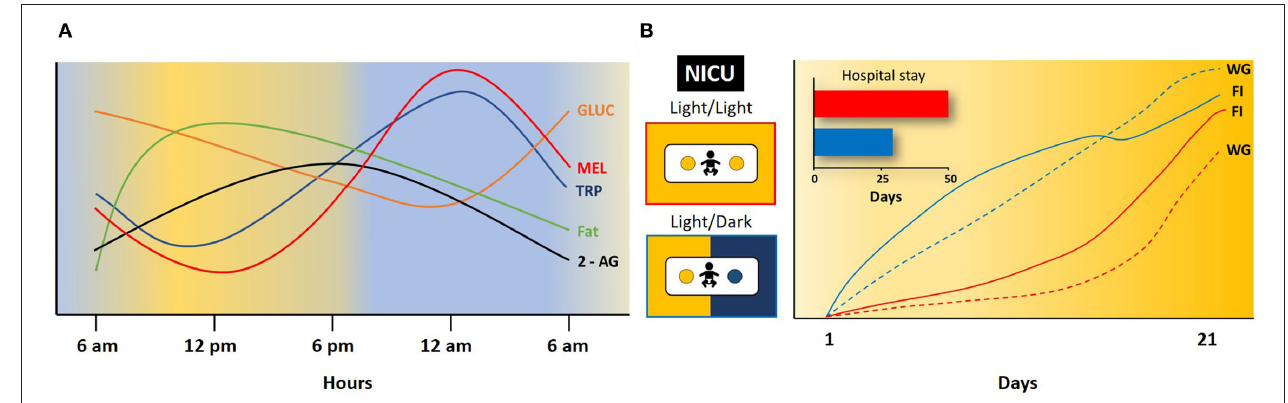
FIGURE 2 | Daily rhythm in some milk components and effect of light/dark conditions on infant development. (A) Changes in concentration of glucocorticoids (GLUC), melatonin (MEL), tryptophan (TRP), fat and 2-arachidonoyl glycerol (2-AG) in 24h. Modified from (5, 6, 33, 35, 36). (B) Effect of constant light (Light/Light) or 12h light and 12h dark (Light/Dark) on food intake (FI), weight gain (WG), and length of hospital stay in infants at the neonatal intensive care unit (NICU). Blue line and dashed lines infants in Light/Dark; Red line and dashed lines infants in Light/Dark. Note the shorter hospital stay and the increase in food intake and weight gain in infants in Light/Dark cycle in comparison to infants in Light/Light conditions. Modified from